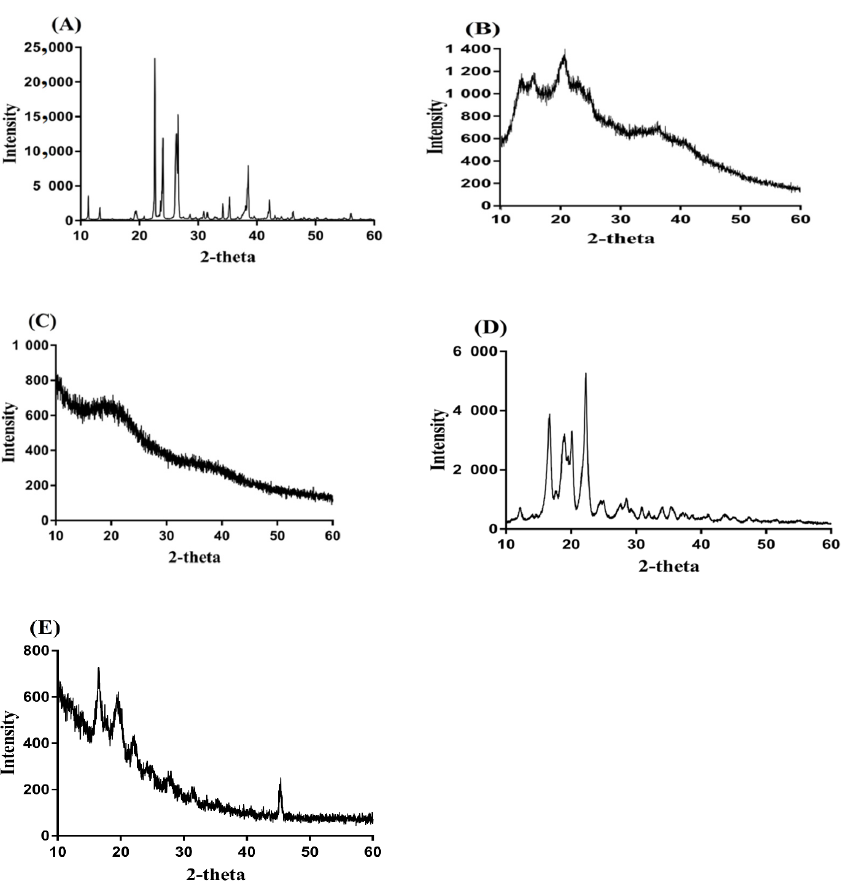
Figure 4. PXRD of ( A ) Aspartic acid (ASP), ( B ) Alginate (AL), ( C ) unloaded ASP/ALPAA hydrogels, ( D ) Ibuprofen (IBP), and ( E ) drug-loaded ASP/ALPAA hydrogels.